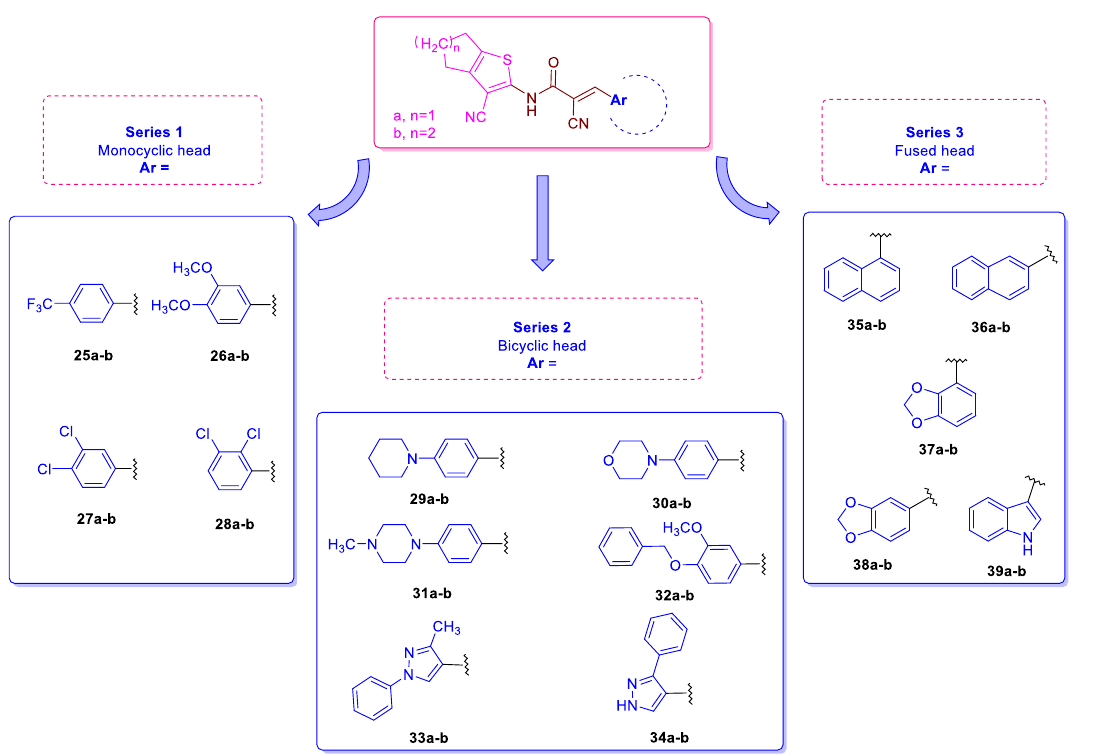
Figure 3. The workflow of three different series showing the chemical structures of 30 novel com- pounds designed as telomerase inhibitors.